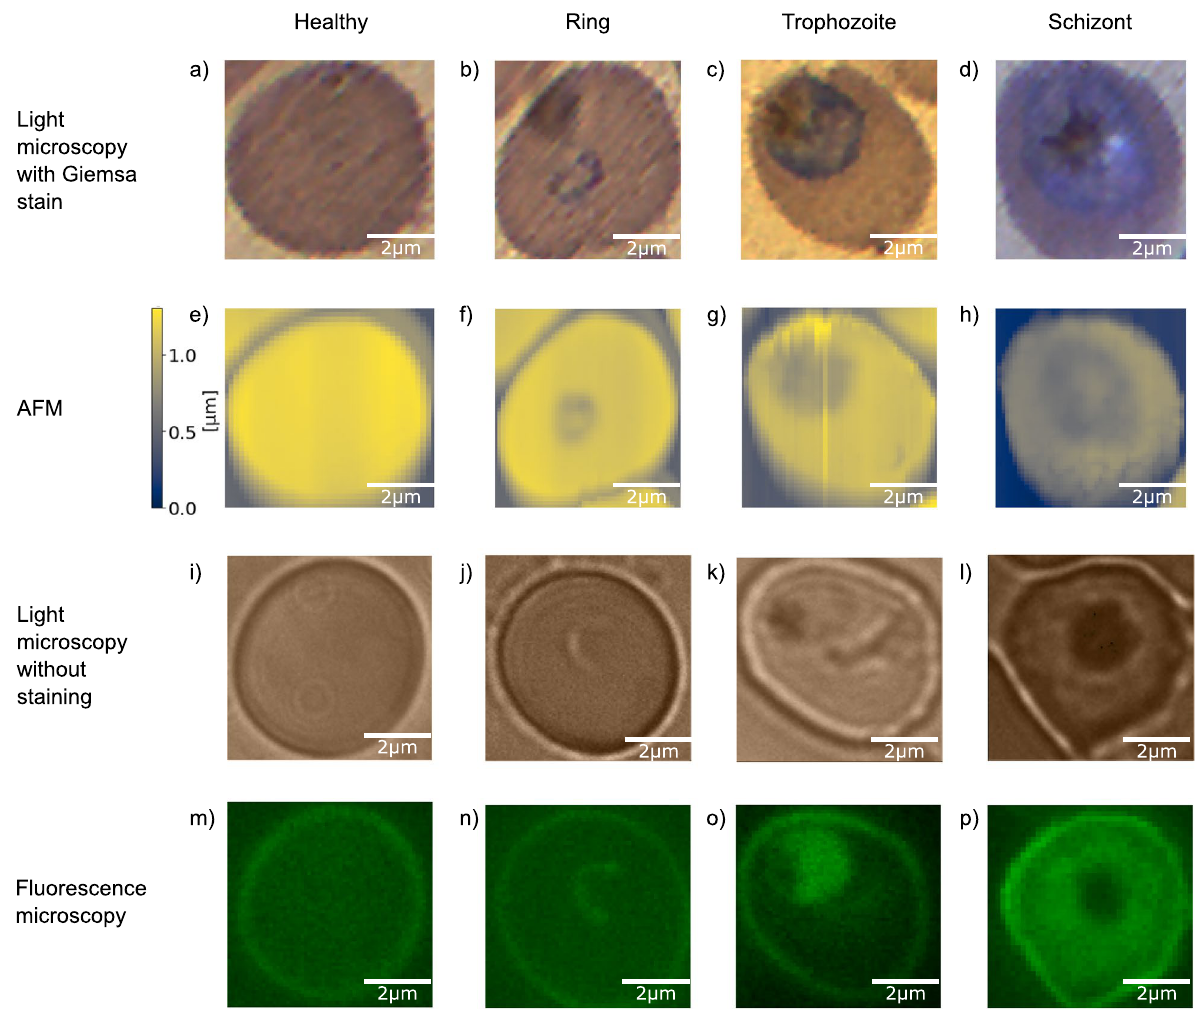
Figure 2. Representative microscopy images of malaria blood stages: healthy, ring, trophozoite, and schizont stage red blood cells are shown in columns respectively from left to right. Images in the different rows are recorded, using different imaging techniques. ( a – d ) Light microscopy images of Giemsa-stained RBCs. ( e – h ) Atomic force microscopy was used to obtain topography images on the same RBCs as in the row above. The colour bar left of ( e ) indicates the height scale common for all topography images. ( i – l ) Unstained light microscopy images, showing a different set of RBCs. ( m – p ) Fluorescence maps of the same RBCs as in the row above. The fluorescence signal was measured after excitation at 405 nm without using dyes.